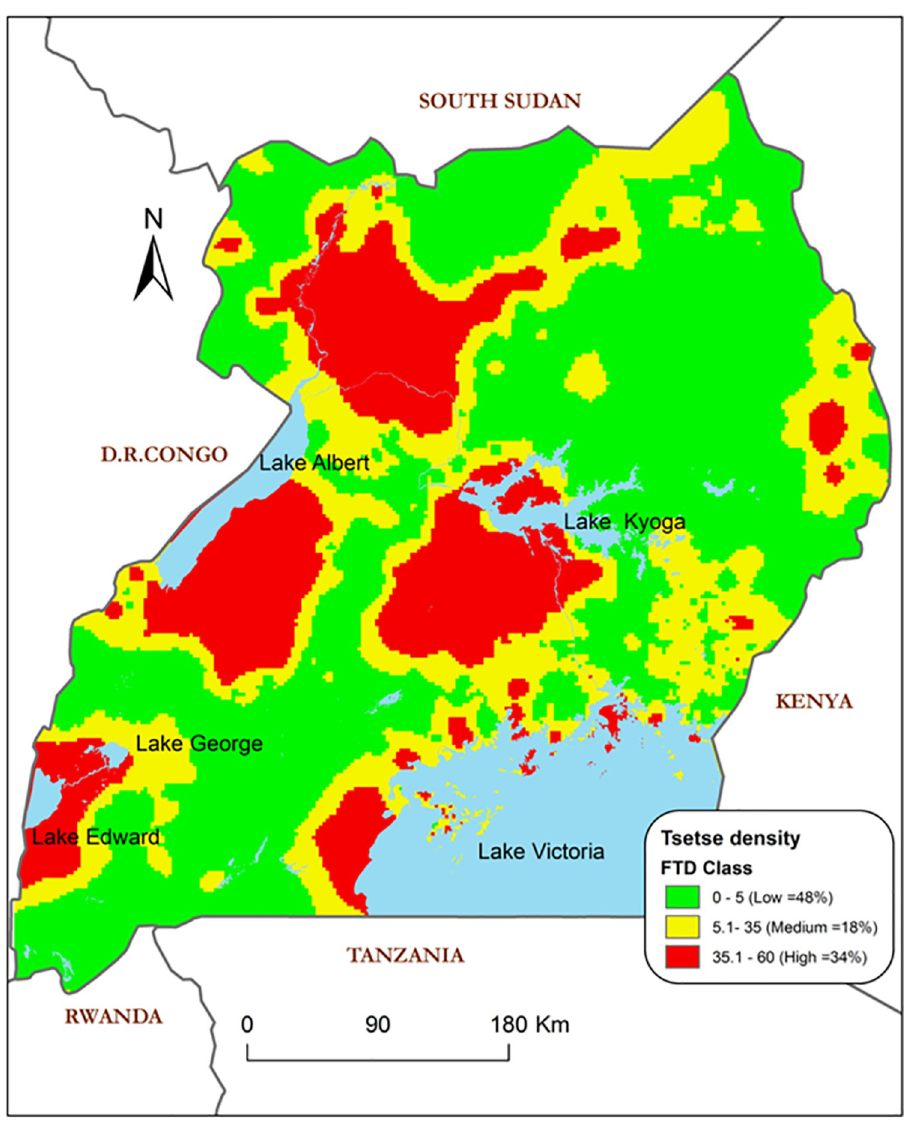
Fig 12. Predicted tsetse fly (Gff) abundance using the ZIP model categorized in three classes. Base map showing country boundaries of Uganda processed from GIS shapefiles obtained from the public domains https://data2.unhcr.